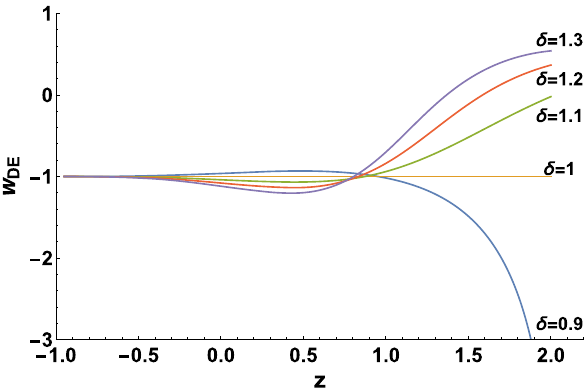
Fig. 2 The evolution of the dark-energy equation-of-state parameter w α = 1inunitswhere H = 1,and DE asafunctionoftheredshift z ,for 0 various values of the nonextensive parameter δ . For each value of δ we choose (cid:3) according to (30) in order to obtain (cid:4) m ( z = 0 ) = (cid:4) m 0 ≈ 0 . 3 at present, and acquire an evolution of (cid:4) DE and (cid:4) m similar to the upper graph of Fig.